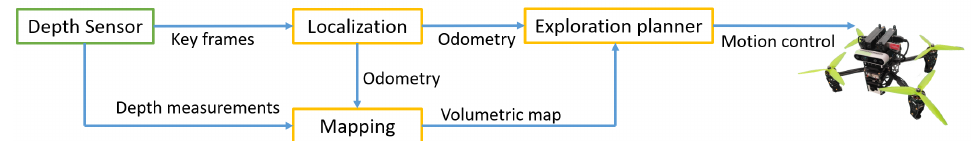
Figure 1. The system overview. The modules of localization, mapping, and planner are run on the UAV. The UAV visits unknown spaces independently according to the outputs of the exploration